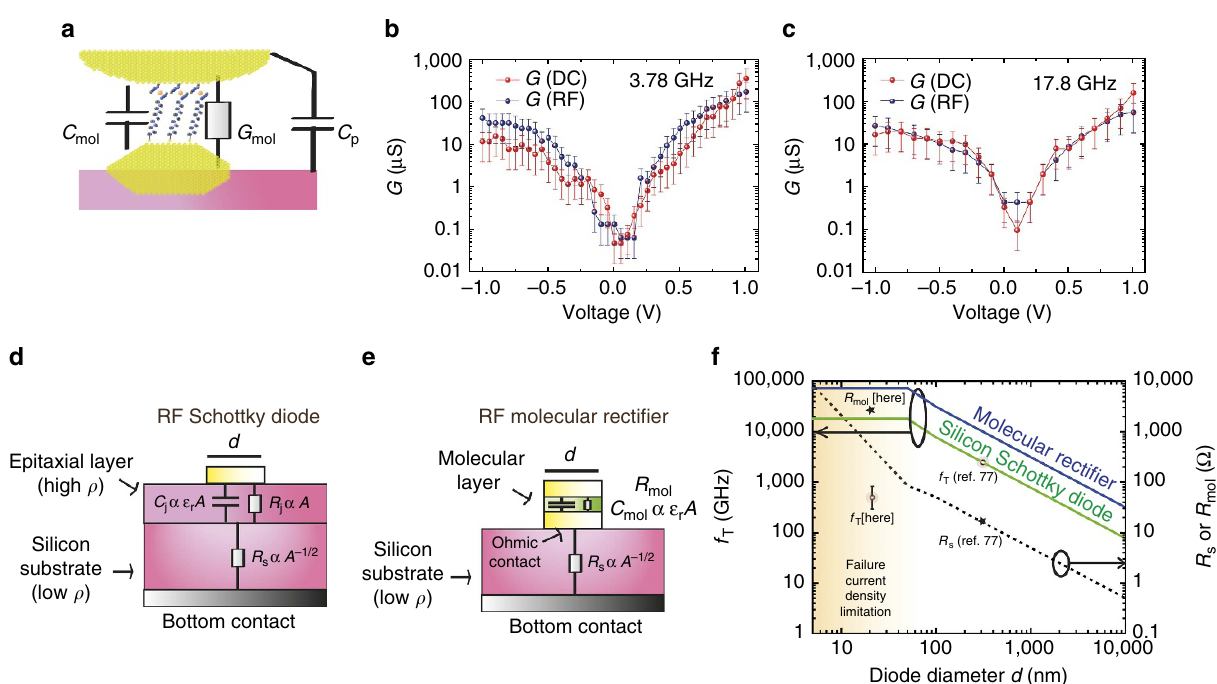
Figure 4 | Perspectives for RF-molecular rectifiers. ( a ) Equivalent circuit representation of the device. Molecules can be decomposed as a conductance in parallel with a capacitance ( G mol and C mol ). Also, a fringe capacitance ( C p ) between the iSMM tip and the sample has to be considered. ( b ) Conductance G mol estimated from both the d.c. measurement ( d I / d V ) —red curve—(technically obtained after multi-exponential fit with 200 points of the d.c. I – V curve: 21 points), and from S 11 parameters (equation1)—blue curve—(see Supplementary Information, section 8 for fitting details). The error bar in log scale is considered to be the same as that of full width half maximum in current histograms. ( c ) Similar curves as in b at 17.8GHz. The error bar in log scale is considered to be the same as that of full width half maximum in current histograms. ( d ) Schematic cross section of the RF Schottky diode architecture. The high resistivity epitaxial layer is thin (few nm) so as to to tune R j up to R s , but not too thin to avoid a large C j . The substrate is highly doped (resistivity r s ¼ 0.001 O cm). Its resistance scales as A 1/2 where A is the junction area. ( e ) Schematic cross section of the proposed RF molecular rectifier. The molecular layer plays the role of the diode with a small dielectric constant r r . Similar to Schottky diodes, the molecular diode is connected to a highly doped silicon substrate. ( f ) Graph illustrating the theoretical (ideal) f T and resistance ( R s or R mol ) for both the RF-molecular rectifier and the RF-Schottky diode architectures shown in d , e . The dash curve corresponds to R s ¼ r s /2 d with r s ¼ 1m O (cid:4) cm (ref. 78). C j /A ¼ 6.2 m Fcm (cid:3) 2 from refs 77,78 and C mol / A ¼ 0.9–1.4 m Fcm (cid:3) 2 based on a dielectric constant of 2–3 for the monolayer and a monolayer thickness of 1.9nm (the length of the molecule). A current density failure limitation of 3 (cid:2) 10 8 Acm (cid:3) 2 from refs 79,80, induces a saturation of f T in the graph. Measured R mol at þ 1V and estimated f T are also indicated. The error bar is related to the conductance dispersion from 2D I–V